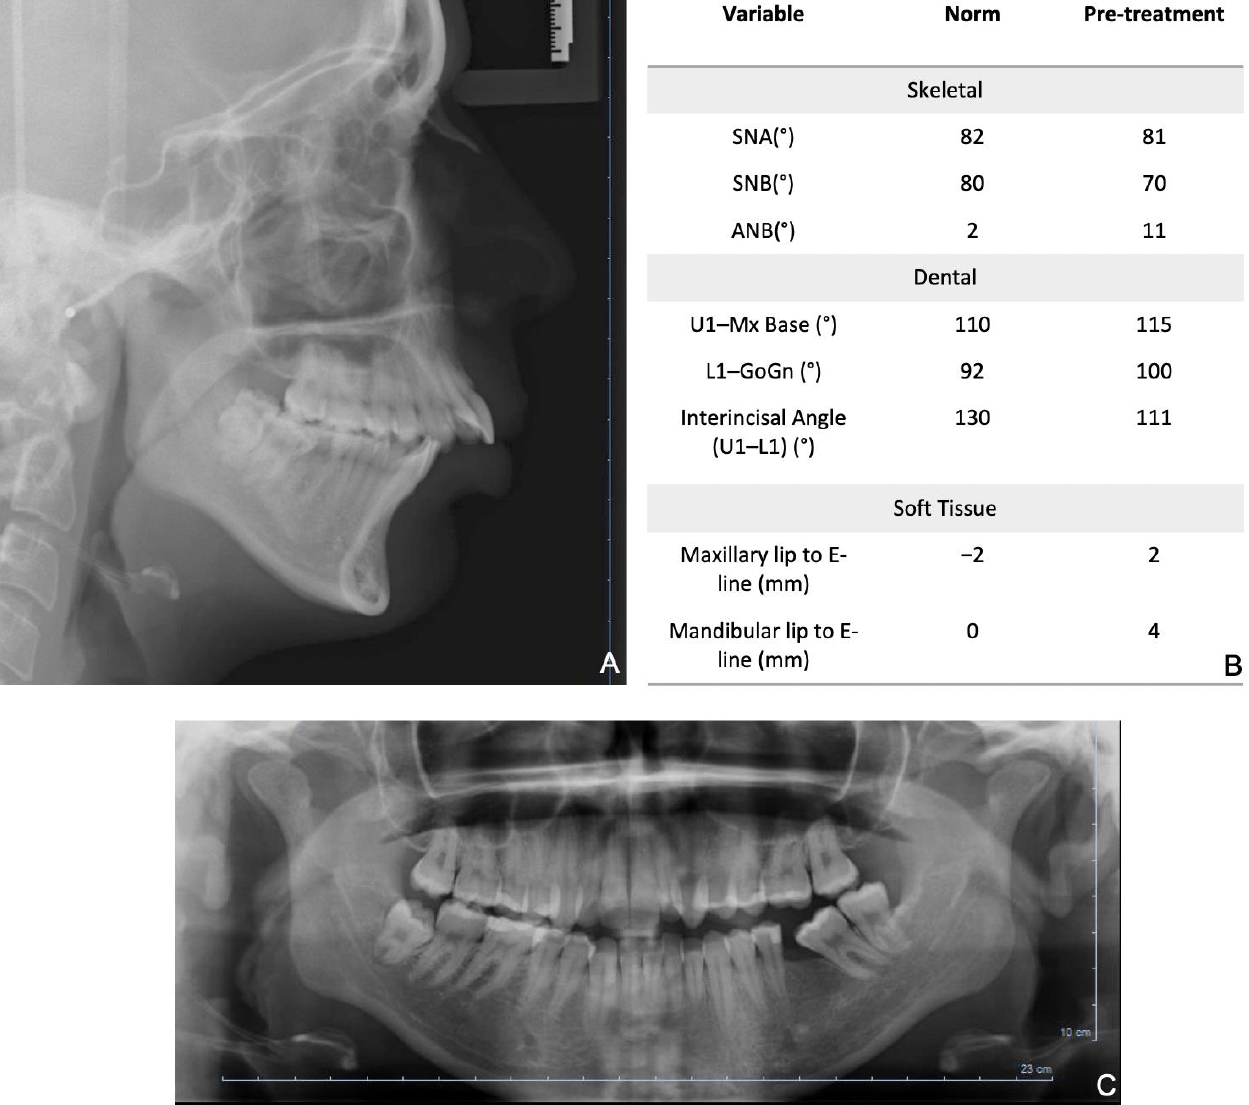
Figure 2. Pretreatment records: ( A ) initial ortopantomography: ( B ) lateral cephalogram; ( C ) initial cephalometric measurement. Initially, both arches were aligned and leveled with fixed orthodontic appliances (Roth 0.018—equilibrium ® 2 Dentaurum, Turnstrabe 31, Ispringen, Germany) for six months